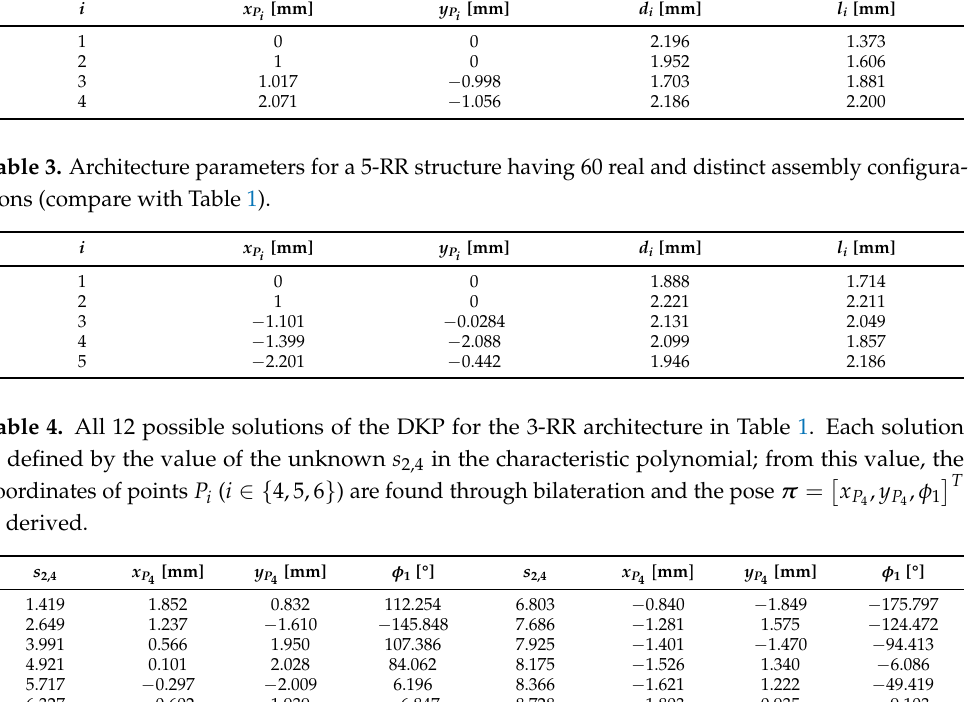
(cid:2) (cid:3) T , y P , φ 1 x P 4 4